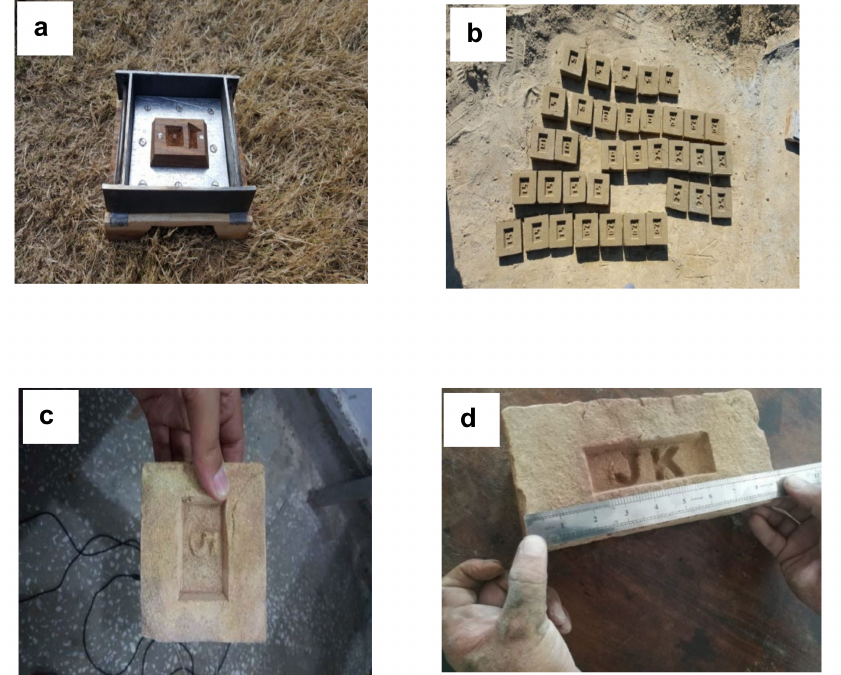
Figure 3. ( a ) Mold of radiation specimen. ( b ) Radiation brick specimen preparation. ( c ) Radiation brick specimen. ( d ) Normal brick